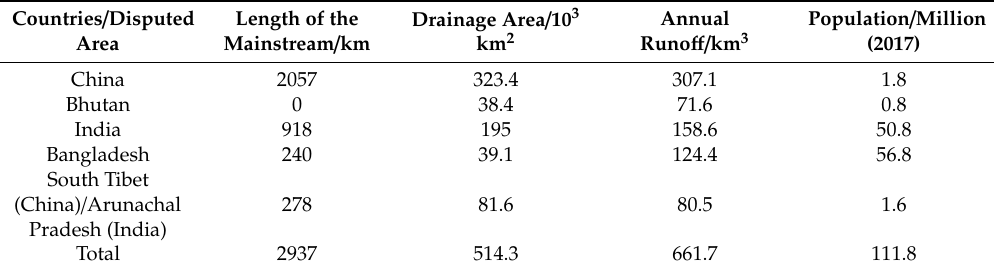
Table 1. Basic information of the Brahmaputra River Basin (BRB) among the riparian countries and the disputed